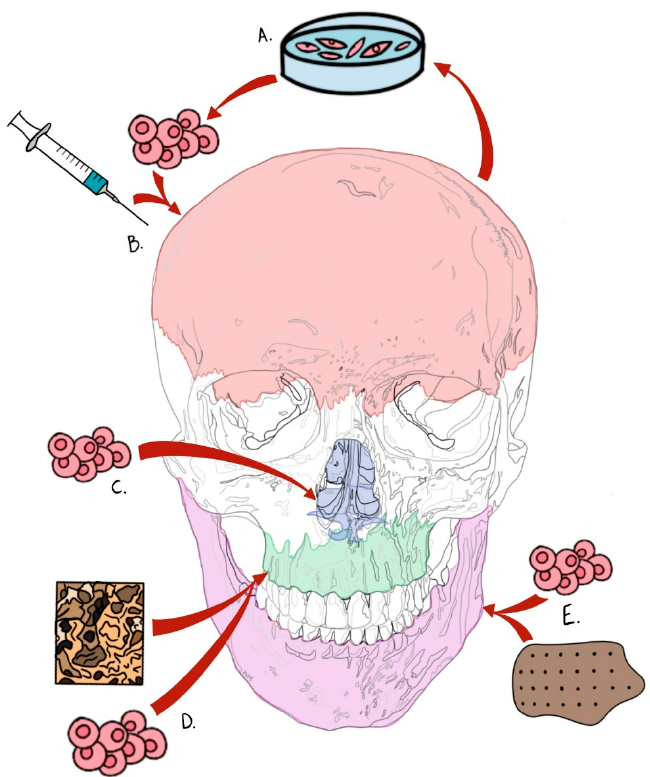
Figure 3. Summary schematic of stem cell-based therapeutics in targeted craniofacial bone tissue engineering. ( A